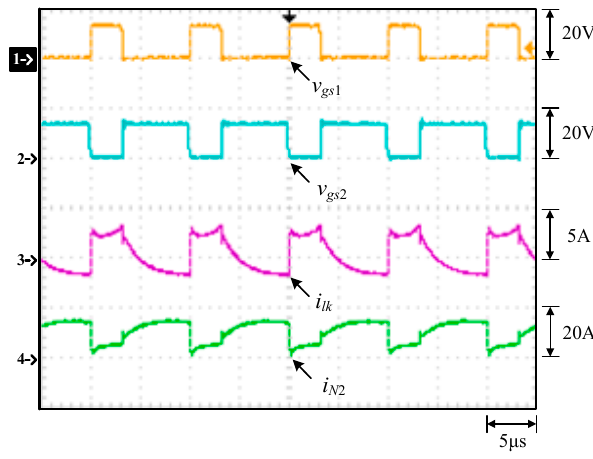
Figure 18. Measured waveforms at rated load: (1) v gs 1 ; (2) v gs 2 ; (3) i lk ; (4) i N 2 .